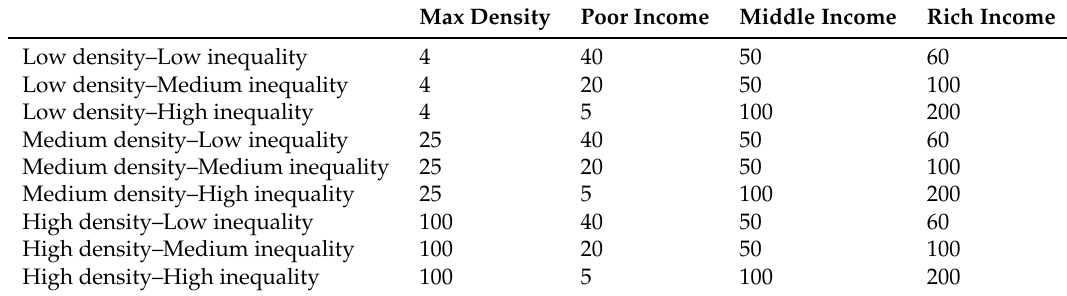
Table 6. Parameter values for each range of configurations of the simulations in the sensitivity analysis.